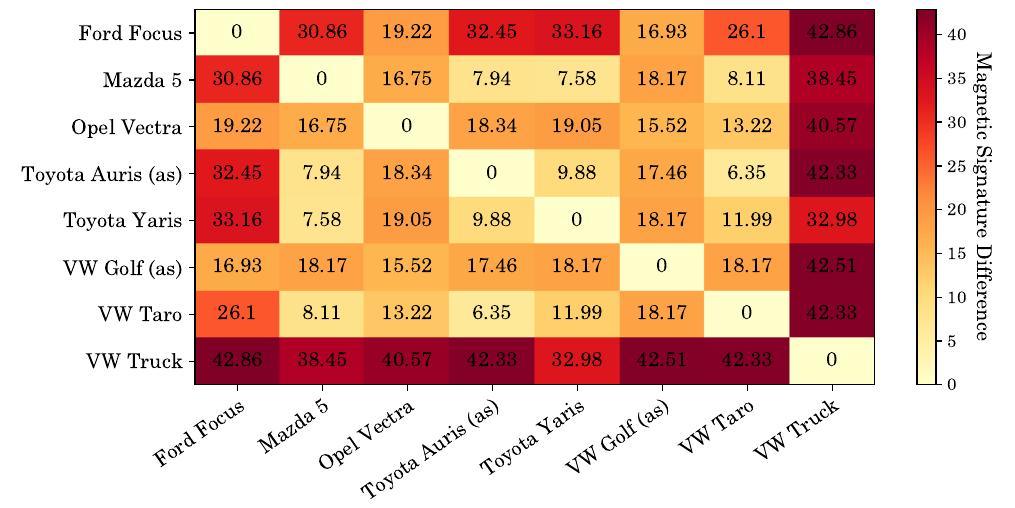
Figure 11. Variation in magnetic field (Z-axis) among vehicles when entering and leaving the parking.